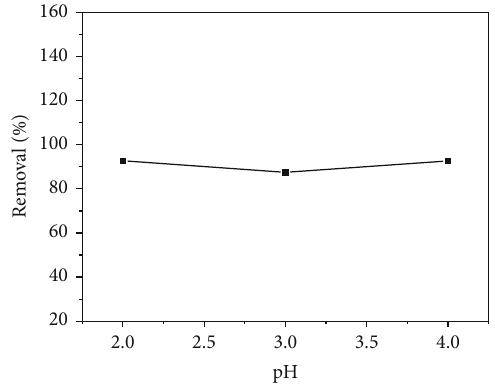
Figure 3: E ff ect of the pH on the removal of iron (III).